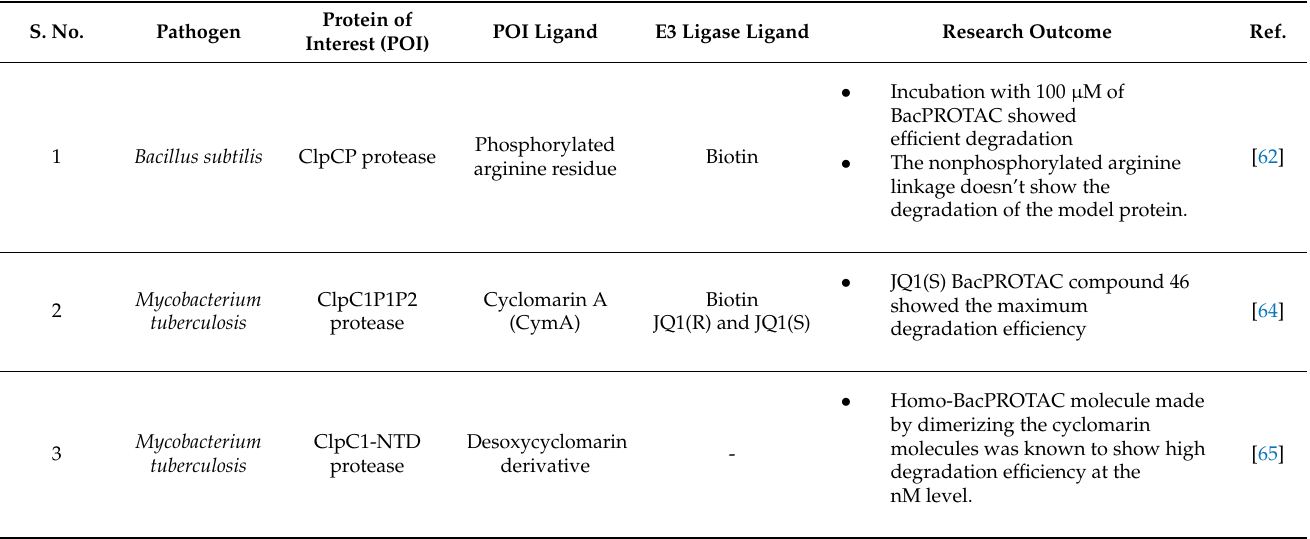
Table 4. Comprehensive information on targeted degradation of bacterial protein in the prokaryotic system using